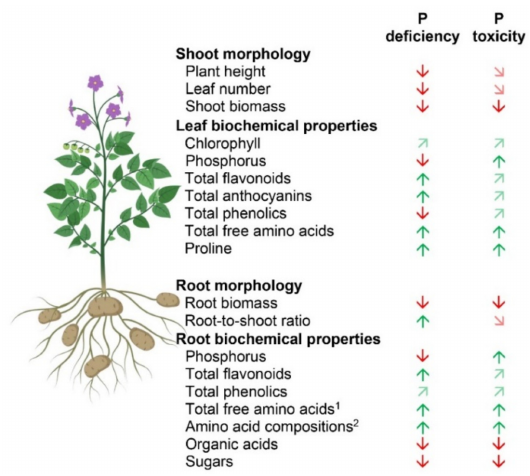
Figure 8. Summary of the morphological and biochemical responses of the potato plants to deficient and toxic P conditions. Green and red arrows indicate significant increase and decrease ( p ≤ 0.05), respectively, compared to optimum P condition. Light green and light red diagonal arrows indicate a tendency of increase and decrease, respectively. 1 based on colorimetric determination; 2 based on nuclear magnetic resonance (NMR) spectroscopy determination. Figure 8 was created